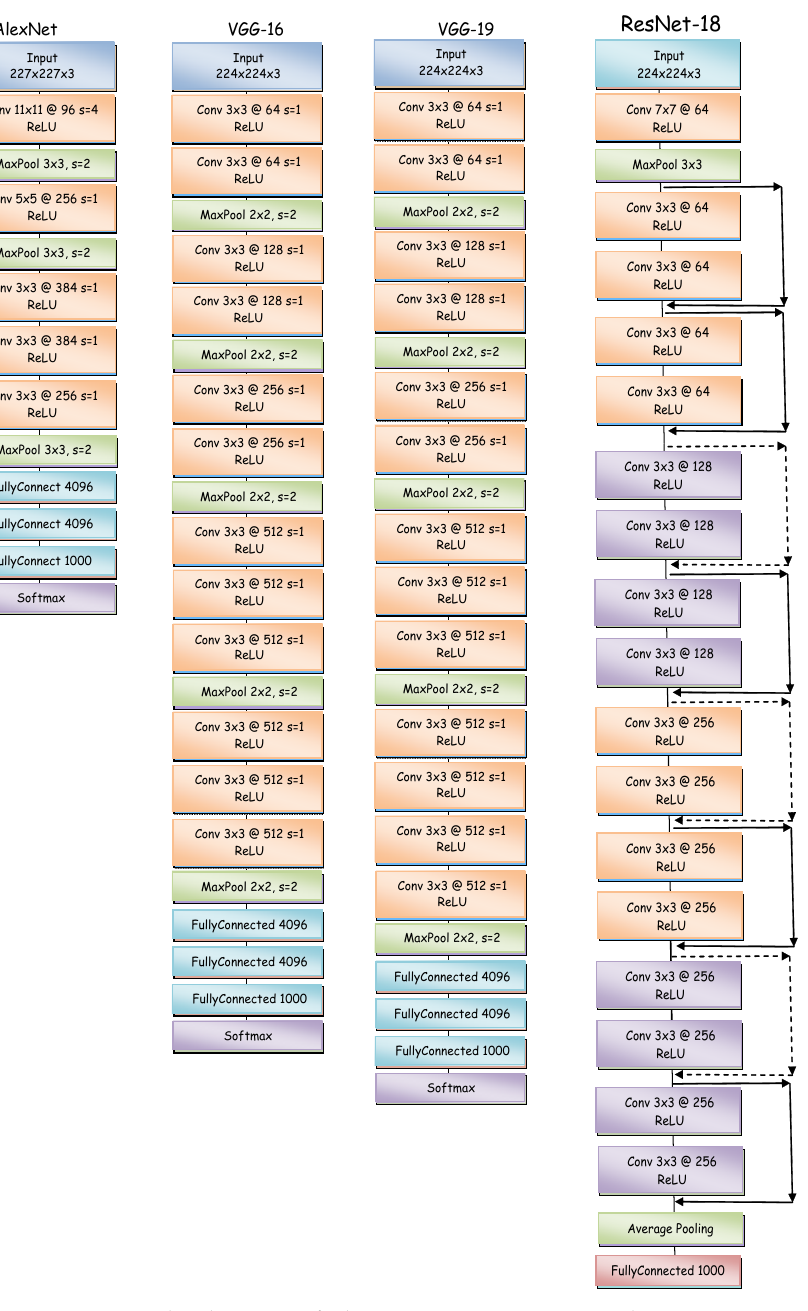
Figure 4. General architecture of AlexNet, VGG-16, VGG-19 and